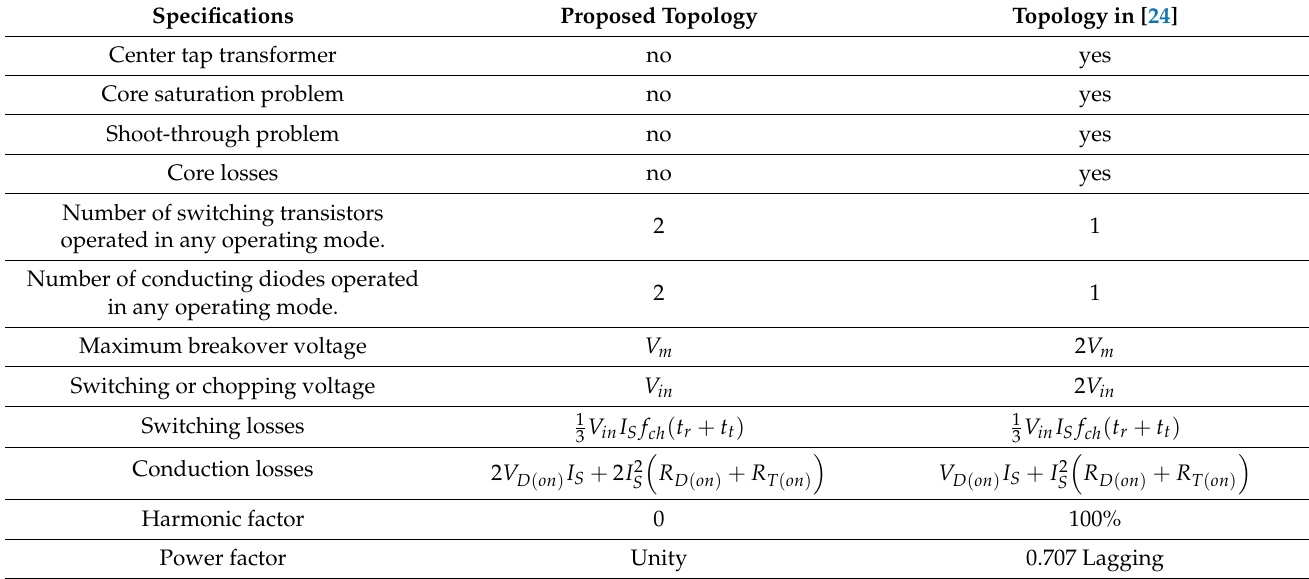
Table 1. Comparison of the proposed topology with the converter in